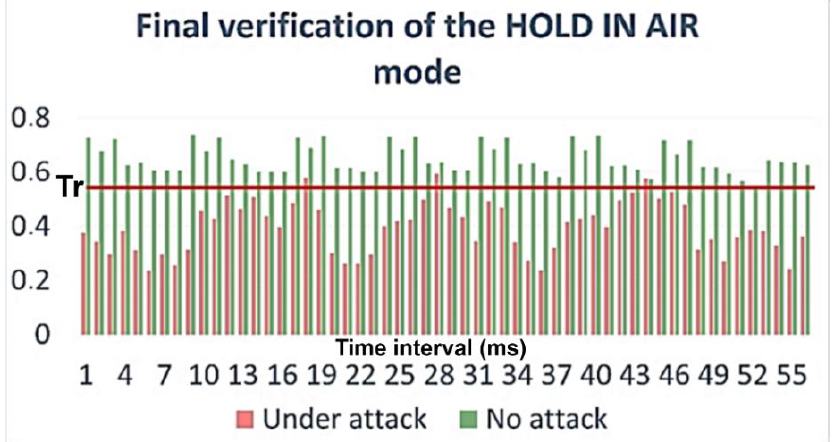
Figure 9. Verification of the HOLD IN AIR mode calculation of the trust function for the current process.